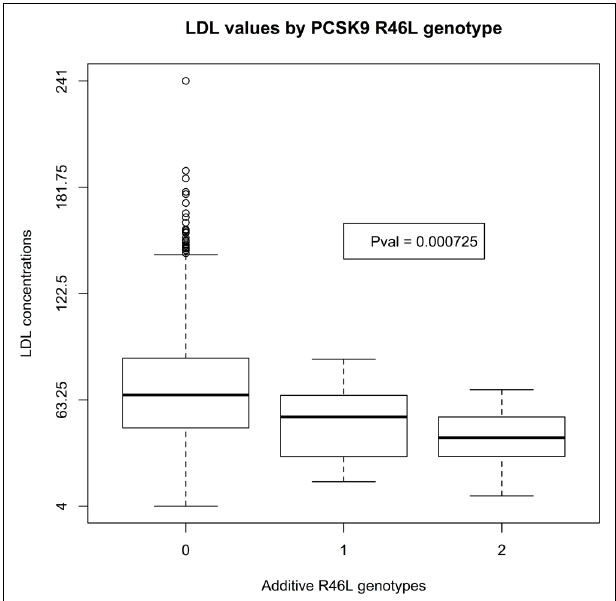
FIGURE 1 | Box and whisker plot of additively encoded PCSK9 R46L genotypes on the X-axis versus age corrected serum LDL concentrations on theY-axis ( n = 1432; min LDL concentration 4; max LDL concentration 241; mean LDL concentration 85). Genotype 0 indicates no copies of the mutant allele, genotype 1 indicates one copy of the mutant allele and genotype 2 indicates 2 copies of the mutant allele.